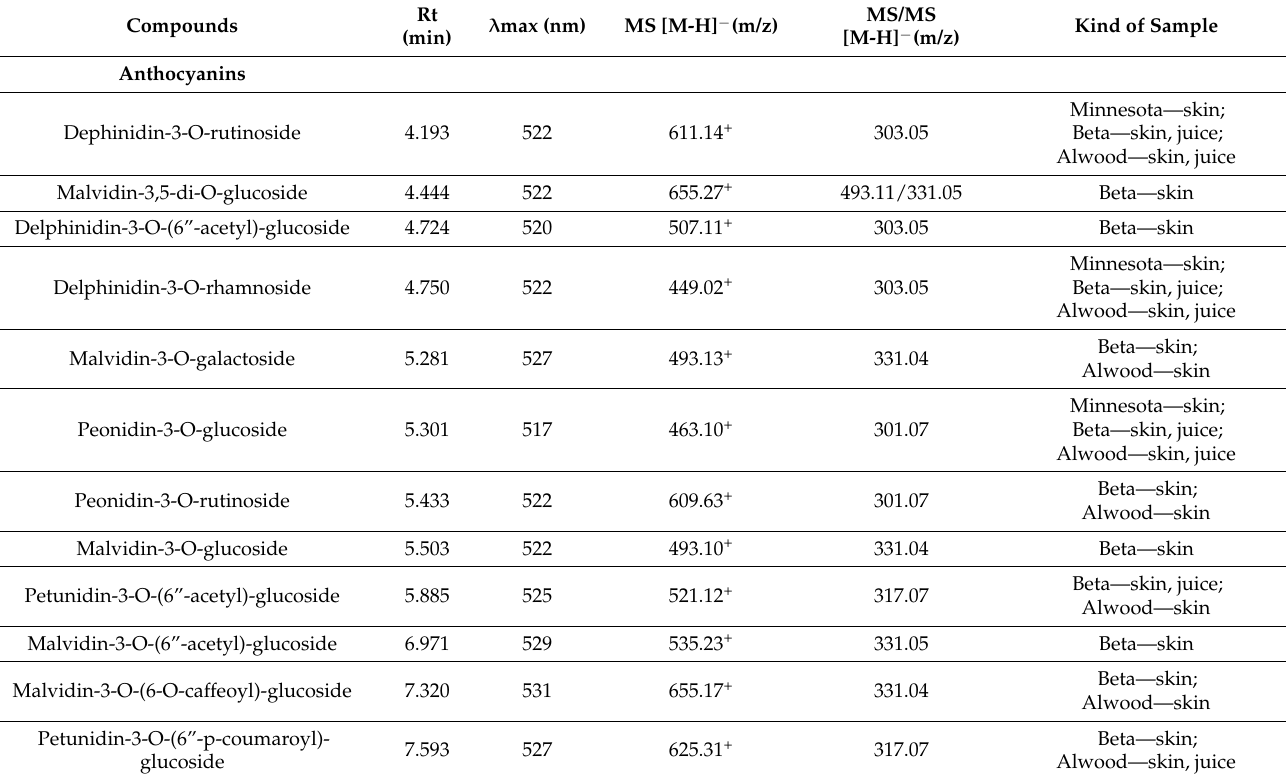
Table 5. Phenolic compounds identified in grapevines hybrids flesh, skins, and juices by LC/MS-